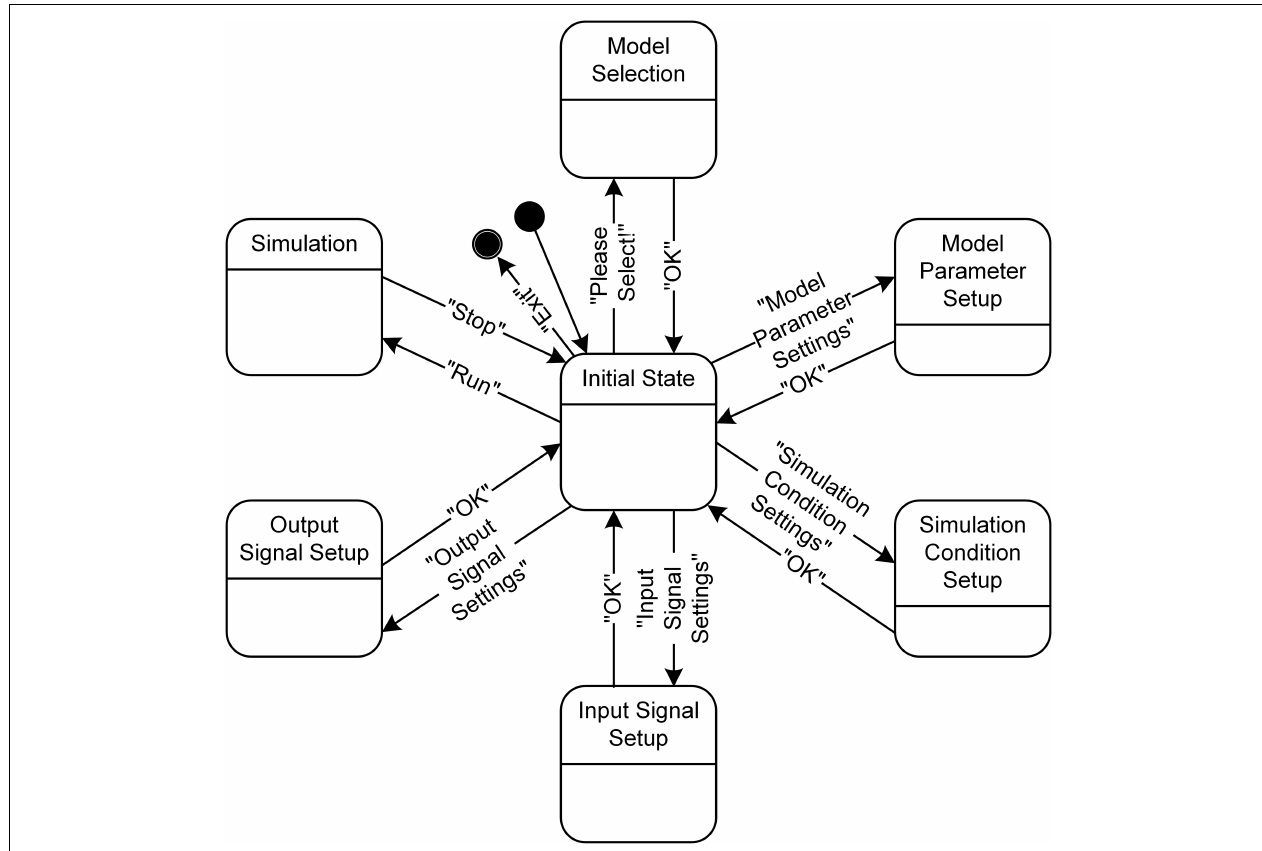
FIGURE 5 | State diagram for PyMUS. PyMUS can transition back and forth between the initial state and the other main states (Model Selection, Model Parameter Setup, Simulation Condition Setup, Input Signal Setup, Output Signal Setup and Simulation) according to the event triggered by the button in the GUI window. The black filled circle without and with an additional black circle represent the start and end of the software